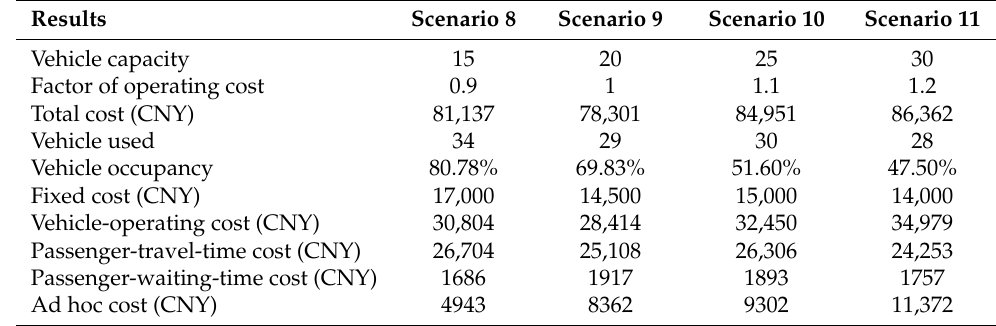
Table 10. Results under different vehicle capacities and operating costs in Shenzhen airport.